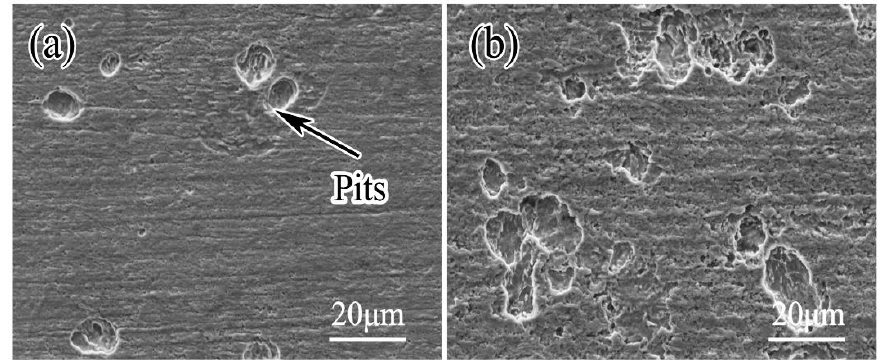
Figure 5. SEM images of specimen surface with corrosion products removed in the abiotic ( a ) and inoculated solutions ( b ) after 14 days.